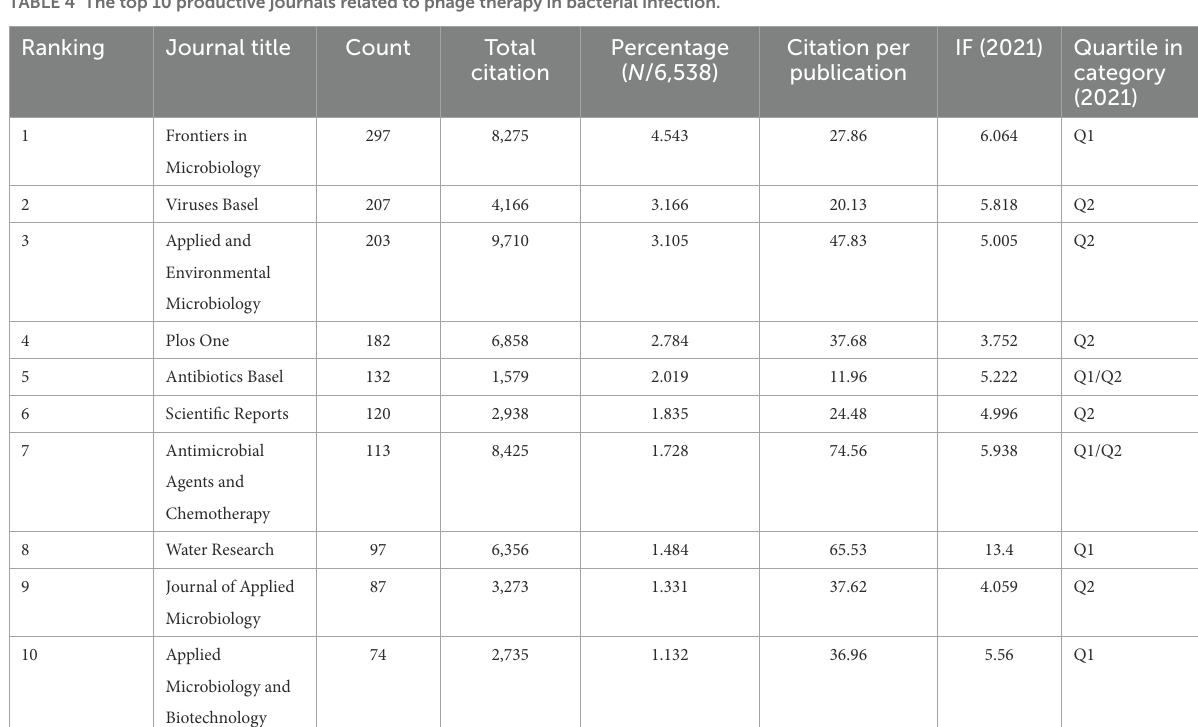
TABLE 4 The top 10 productive journals related to phage therapy in bacterial